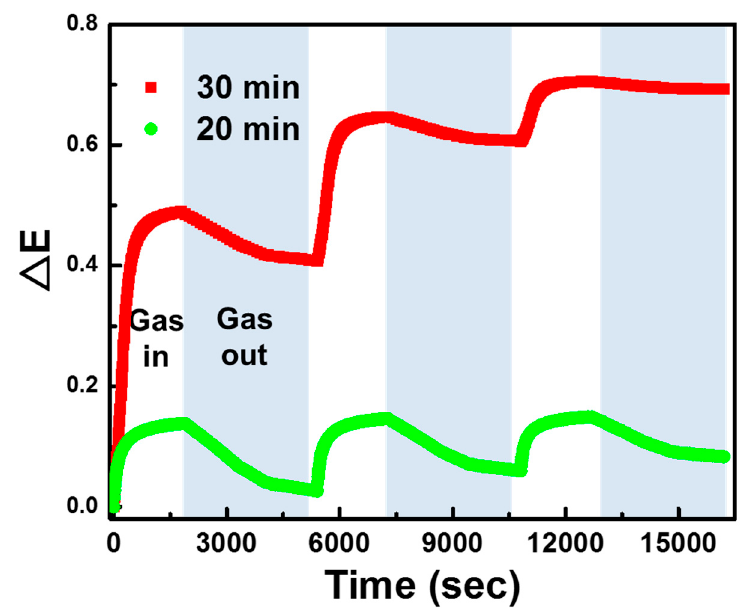
Figure 9. Reversibility of PANI/P3TI/PMMA fibers with 20 min and 30 min of UV/ozone treatment as exposed to 2000 ppm n-butanol.